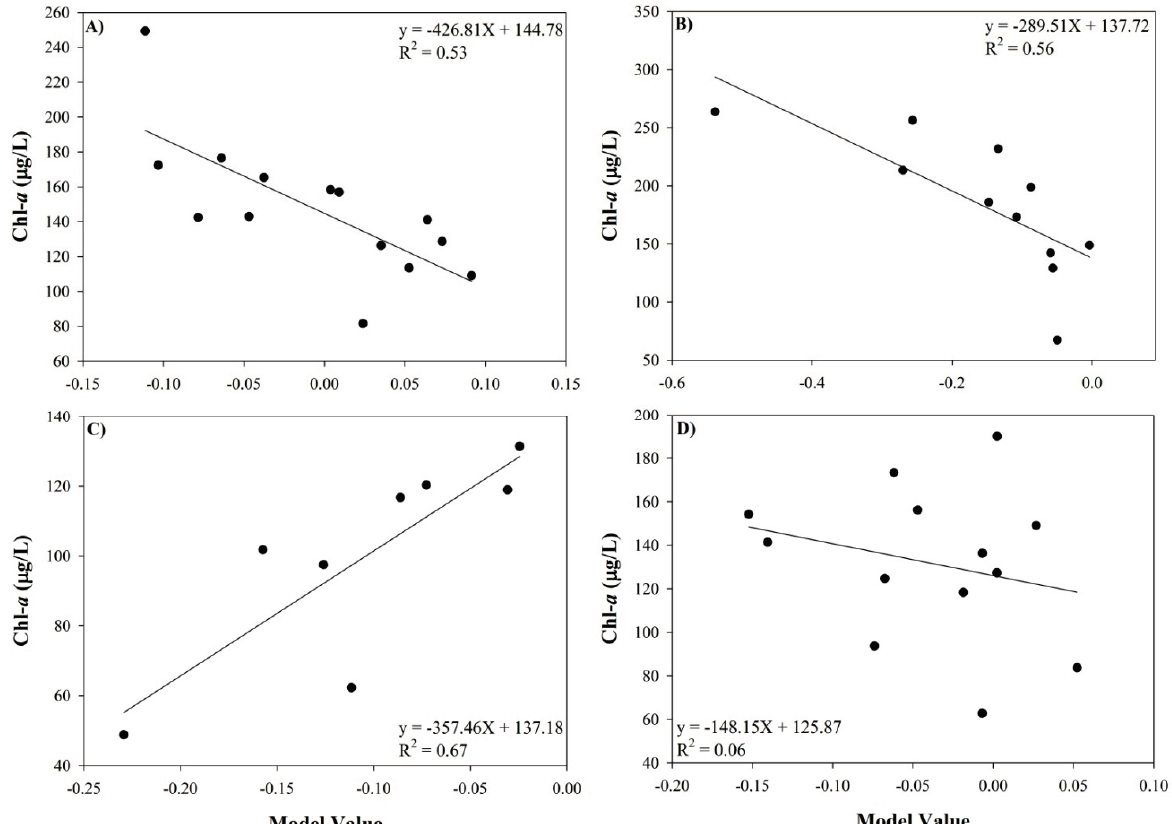
Figure 7. Linear regression plots of the calibration between model values and chl-